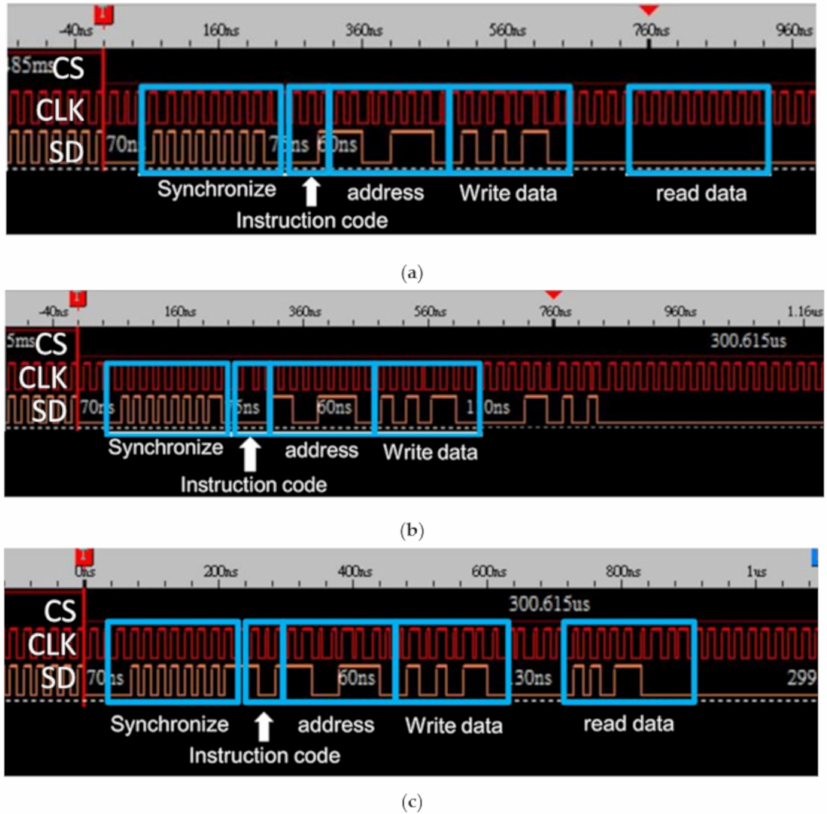
Figure 12. The low-power synchronous preamble data line protocol waveform in the logic analyzer: ( a ) waveform of reading the initial data from memory; ( b ) the waveform of writing the data to memory; and ( c ) the waveform of reading the updated data from